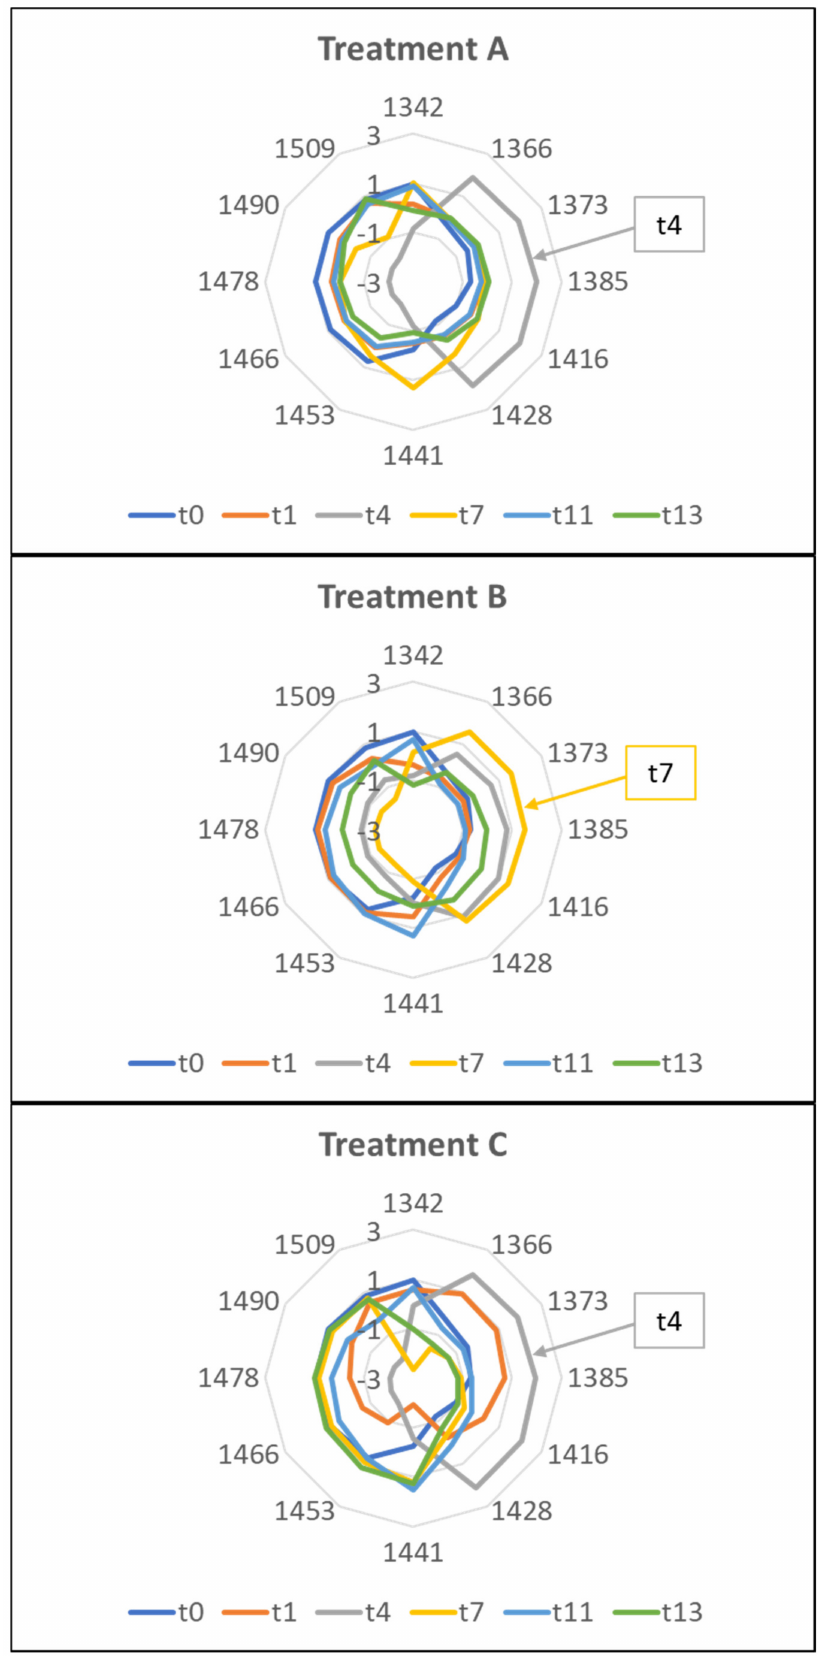
Figure 8. Aquagrams of the rocket samples belonging to the three treatments during the storage: Trial